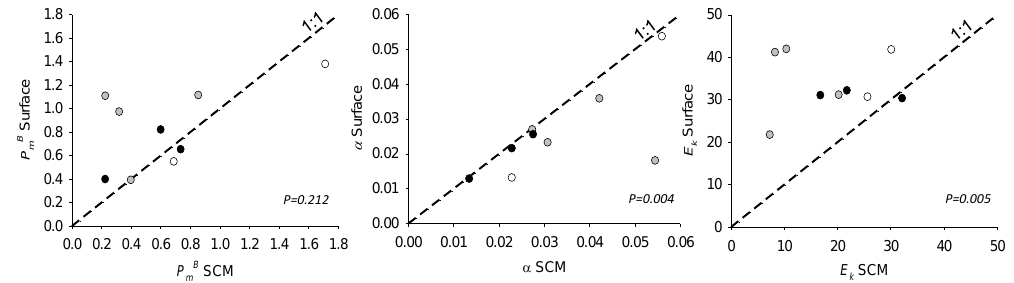
Fig. 2. Comparison of photosynthesis-irradiance parameters ( P B m , α and E k ) between the surface and the SCM in Baffin Bay (black), the Canadian Archipelago (white) and the Beaufort Sea (gray). The level of significance ( p ) for the difference between paired samples is given in each